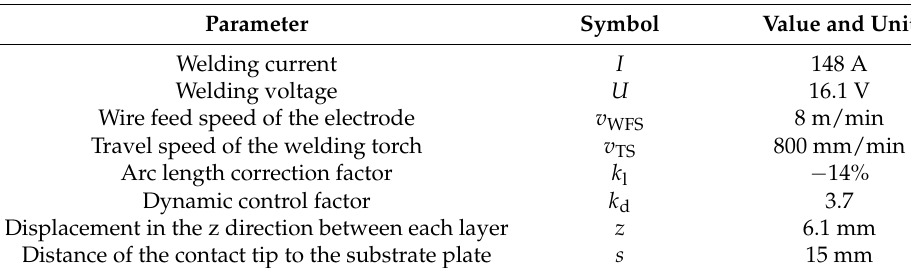
Table A1. Overview of the process parameters.